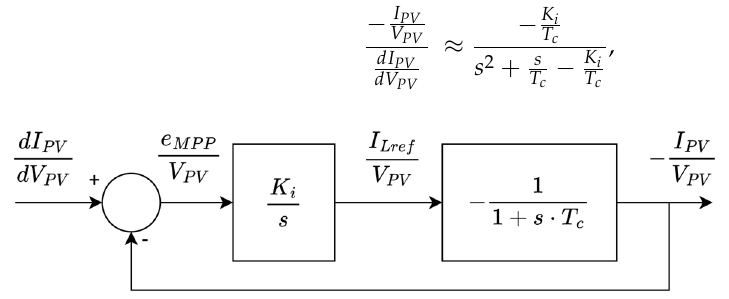
Figure 9. Block diagram of the novel integral compensator MPPT method.